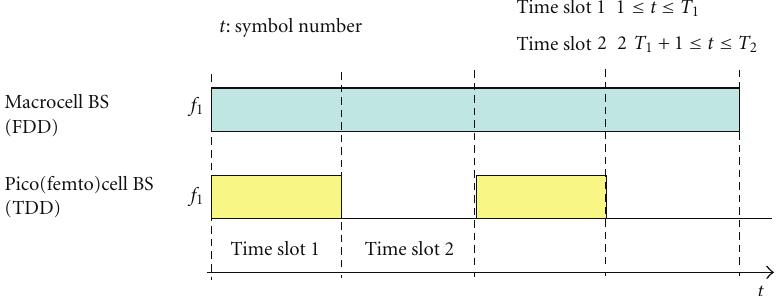
Figure 2: Signal format of base station in macro- and